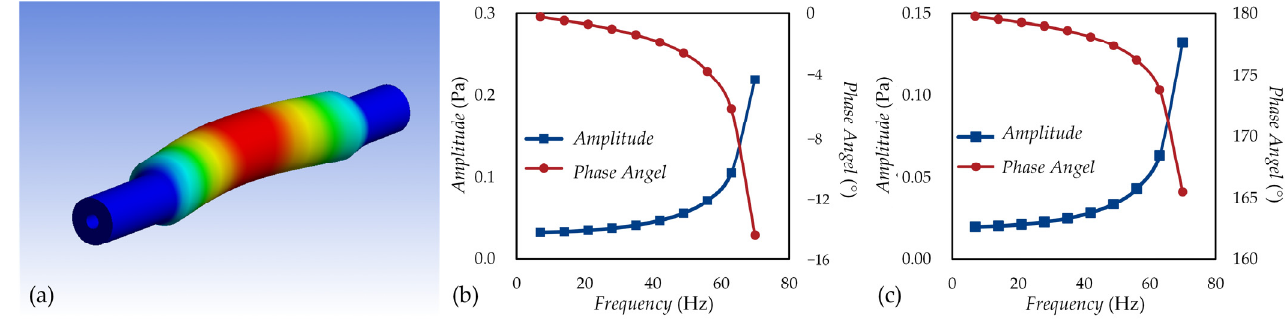
Figure 14. The harmonic response analysis of the secondary resilient bladder: ( a ) mode shape, ( b ) frequency response in the axial direction, and ( c ) frequency response in the radial direction.